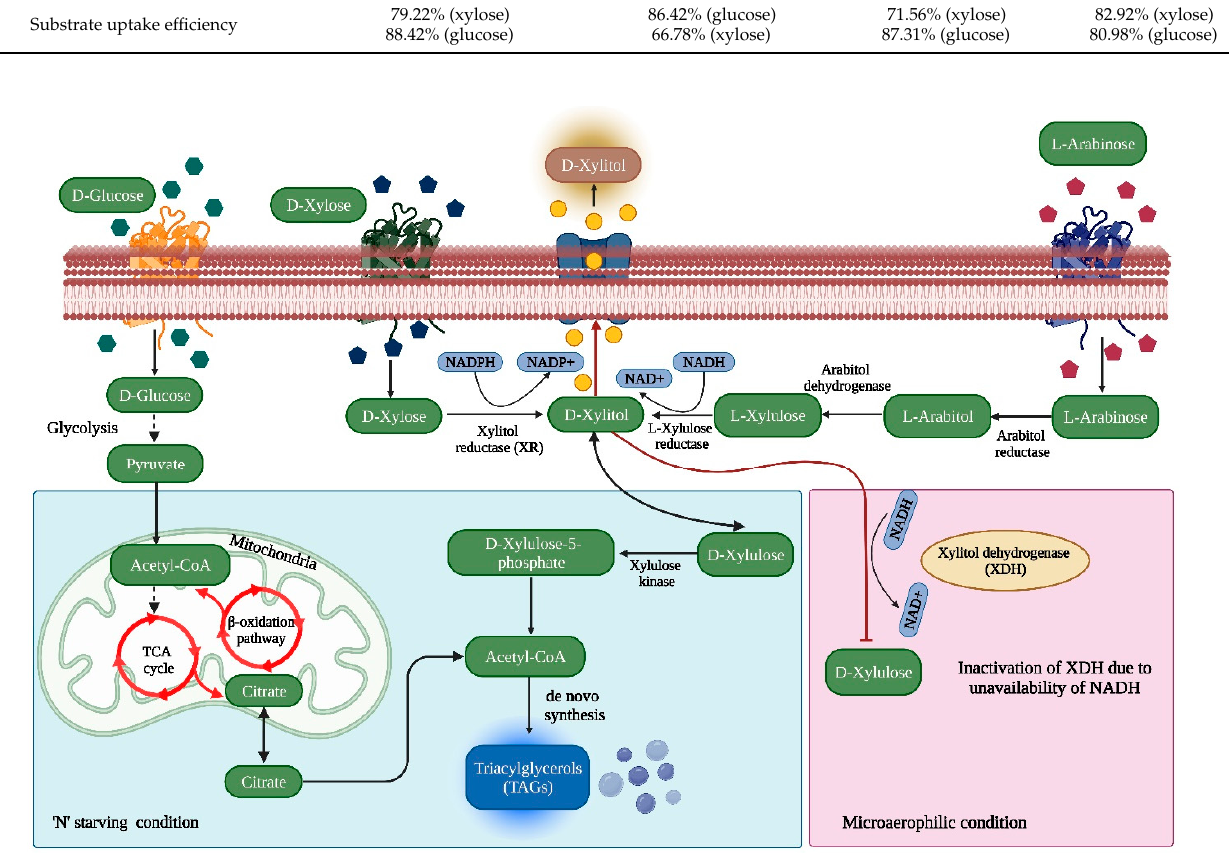
Figure 5. Proposed mechanism of selective uptake of sugars by Rhodosporidium toruloides through alteration of growth conditions (microaerophilic and ‘N’ limitation) for xylitol and lipid synthesis. 3.8. Production of Xylitol from Xylose by Immobilized R. toruloides NCIM 3547 in PBR R. toruloides , the microbial candidate chosen for this study, is a well-known PBRs are used to carry out dynamic fermentation with the use of immobilized cells.